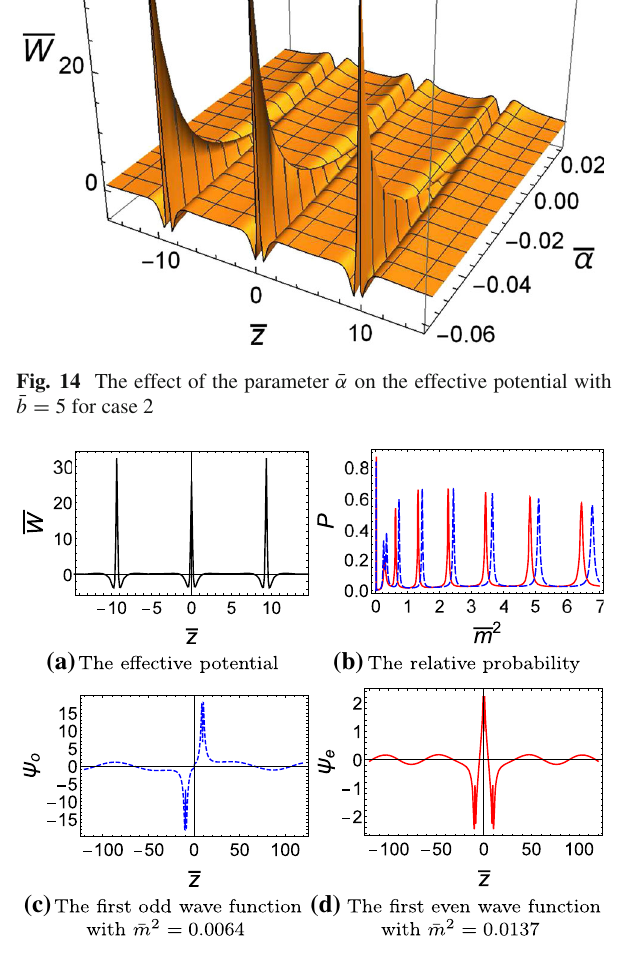
Fig. 15 The effective potential, the relative probability, and wave functions of the first odd and even KK resonance with ¯ b = 5 and ¯ α = − 0 . 0581 for case